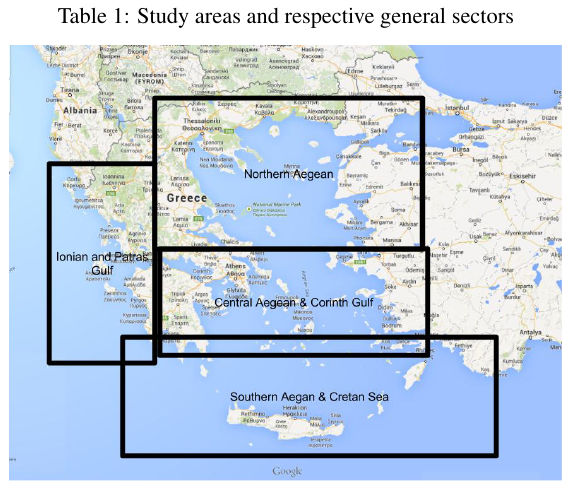
Figure 4: General sectors